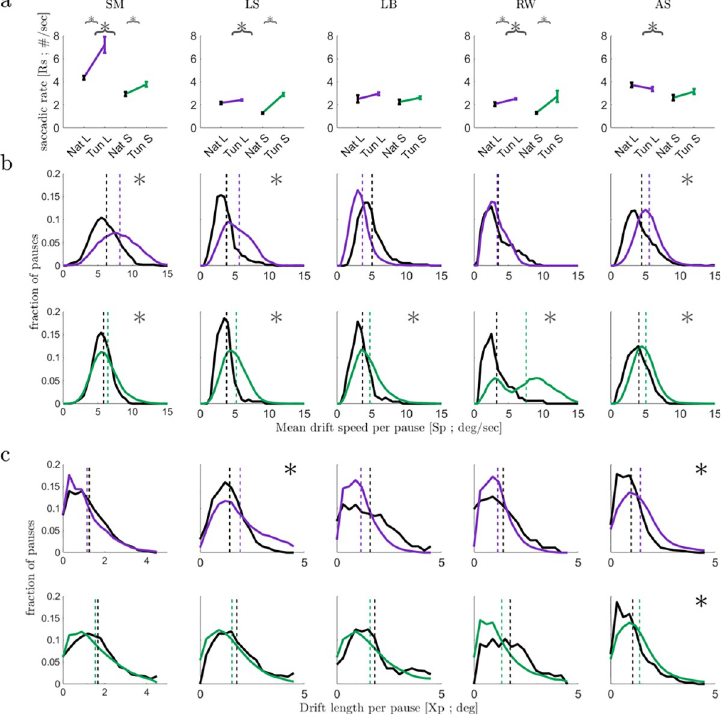
Fig 4. Kinematics of saccades and drifts . (a) Mean saccadic rates ( Rs ) in natural (black) and tunneled viewing for large (purple) and small (green) image sizes. Data for each subject is presented ( � , p < 0.05, two tailed t-tests). (b) Distributions of the mean instantaneous UB-speeds of drifts (target speed values, for time > 50ms) per pause ( Sp ) in the four experimental conditions; data presented as in (a) ( � , p < 0.05, two tailed t-tests). (c) Distributions of the distances travelled during a pause ( drift length; Xp ) in the four experimental conditions; data presented as in (a) ( � , p < 0.05, two tailed t-tests). N’s for Rs statistics in tunneled-large, natural-large, tunneled-small, natural-small, respectively, were: Subj1 (30,19,30,20); Subj2 (29,20,30,19); Subj3 (27,20,28,18); Subj4 (30,20,30,19); Subj5 (25,20,30,20); N’s for Sp and Xp statistics were (respectively): Subj1 (127,497,97,259); Subj2 (92,164,35,491); Subj3 (55,195,41,415); Subj4 (60,115,20,286); Subj5